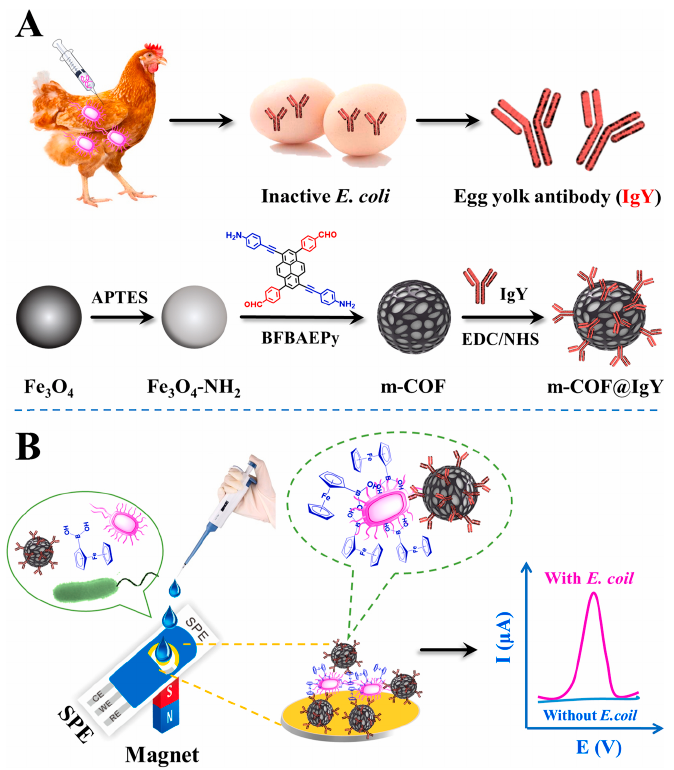
Figure 8. ( A ) Schematic illustration of the preparation process of m-COF@IgY and ( B ) application for determination of E. coli from Ref. [98]. Copyright 2022 Elsevier.